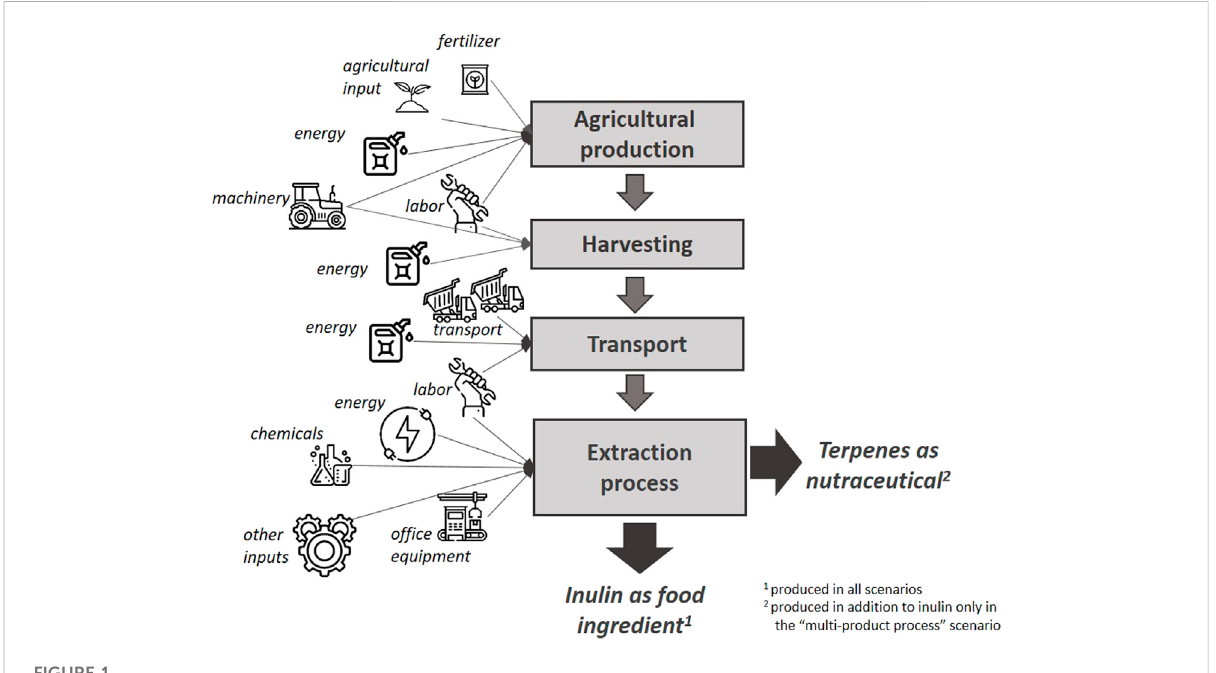
FIGURE 1 Activities included in the analysis – simpli fi ed